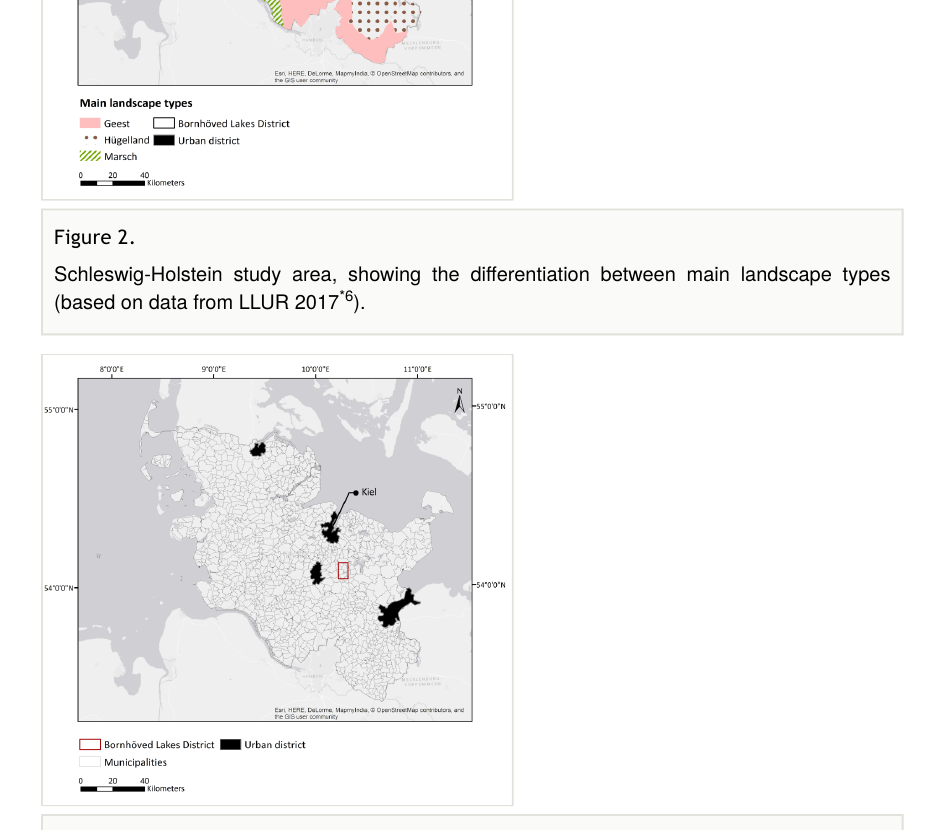
Figure 3. Assessment units for Schleswig-Holstein: Municipalities (data on administrative boundaries from GeoBasis-DE / BKG